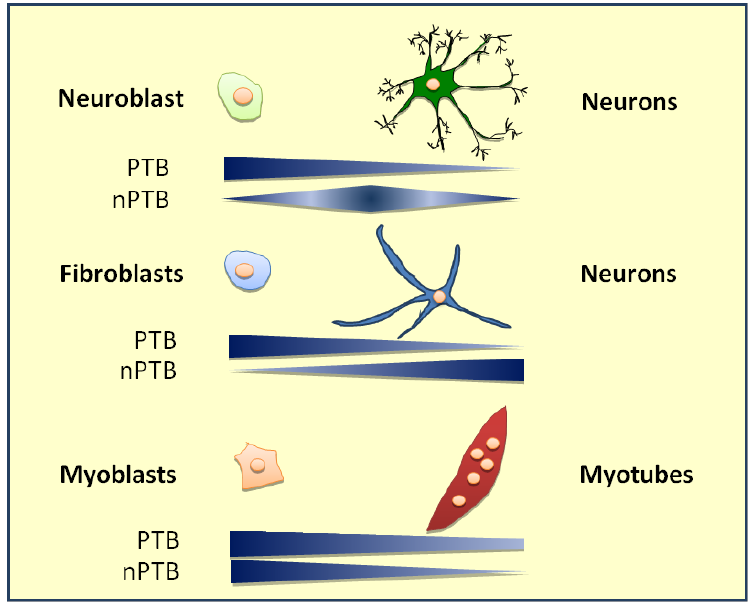
Figure 4. Relative ratio of PTB and nPTB expression during cell